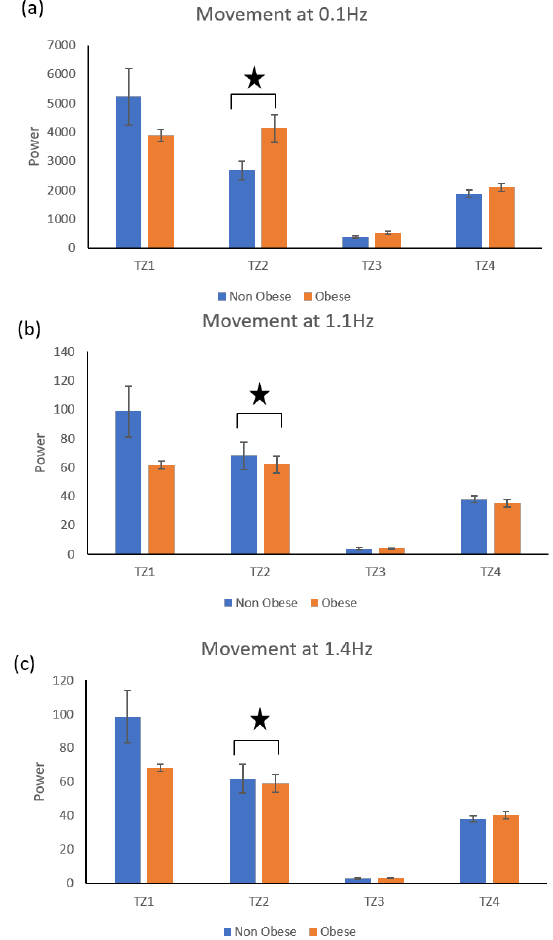
Figure 15. Amplitude of movement at low (0.1 Hz) and high (1.1 Hz and 1.4 Hz) frequencies. Sleep Data Analysis: The average number of transitions in each phase during sleep in obese adults was significantly less than that of non-obese adults (Figure 16).